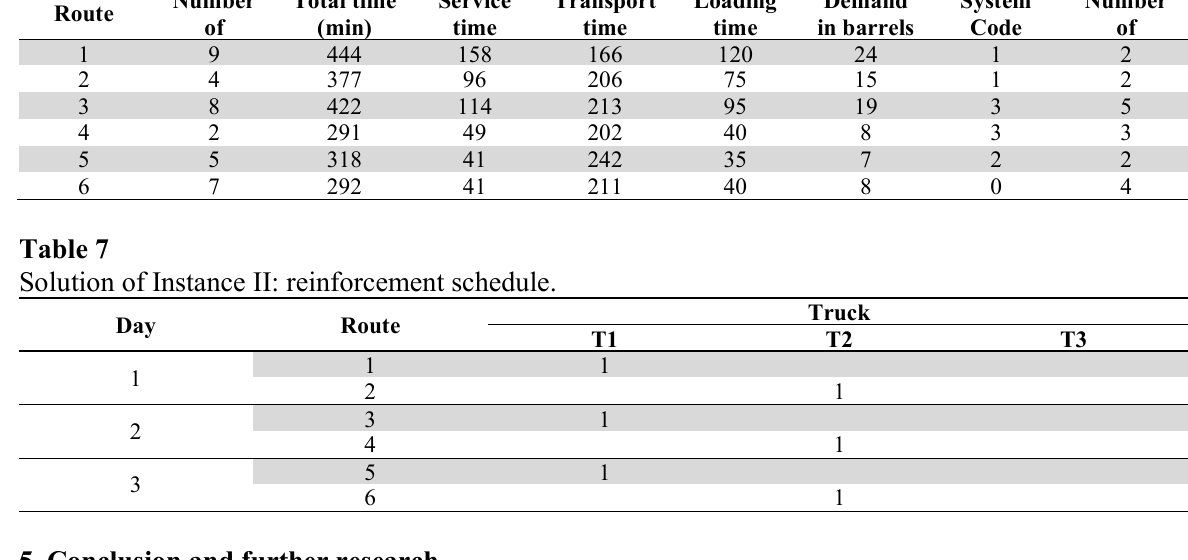
Description of routes in solution of Instance II: reinforcement schedule Route